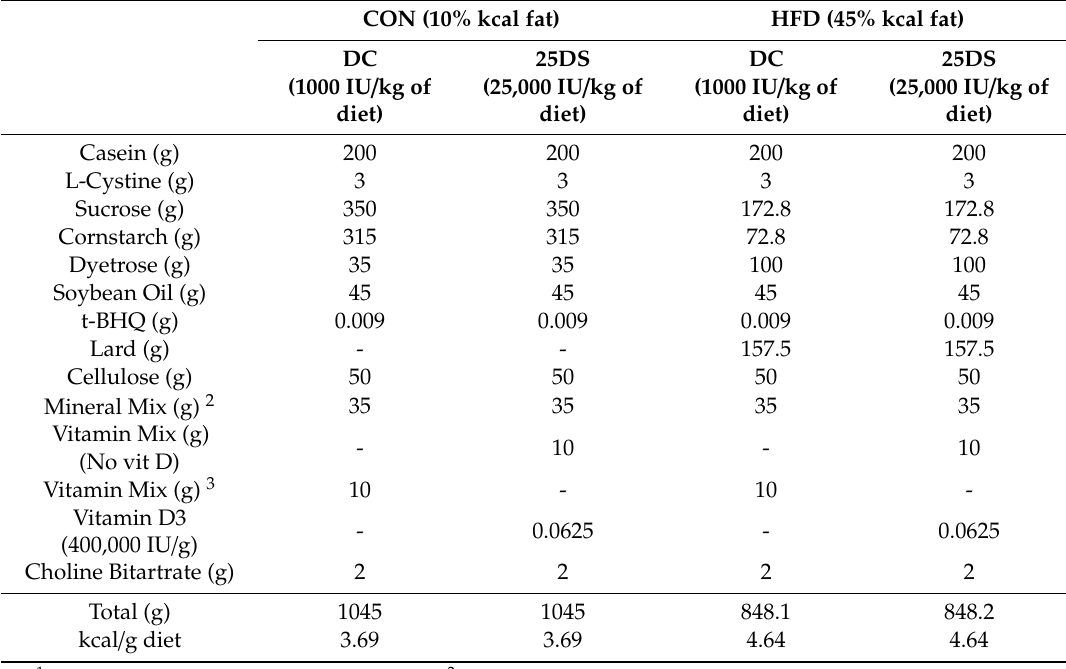
Table 1. Composition of the experimental diets (Exp. 1) 1